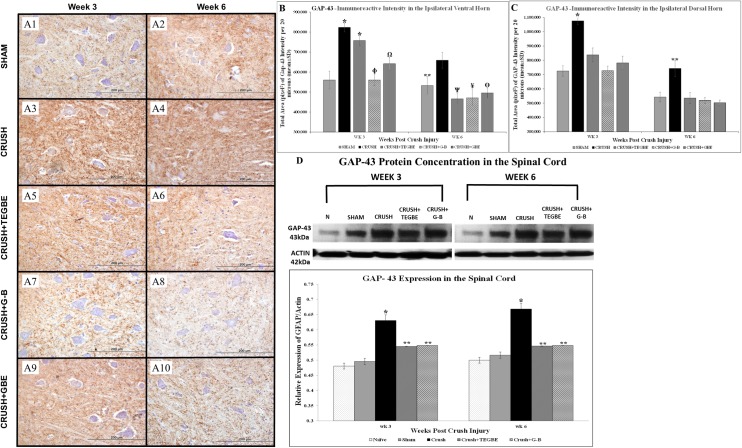
GAP-43 immunoreactivity.A: Representative photomicrographs (40x objective) of ipsilateral ventral grey horn of L3-L6 spinal cords sections from all groups immunostained for GAP-43 (GAP-43 Antibody (B-5): sc-17790 –Santa Cruz Biotechnology) at week 3 (A1, A3, A5, A7 and A9) and week 6 (A2, A4, A6, A8 and A10) following nerve crush injury. Note that the crush group (n = 12) (A3, A4) display a remarkable increase in GAP-43 immunoreactivity when compared to sham (n = 12) (A1, A2) group at week 3 and week 6 post-injury. Whereas treated animals with TEGBE (n = 12) (A5, A6), G-B (n = 12) (A7, A8) and GBE (n = 6) (A9, A10) show a prominent decrease in GAP-43 immunoreactivity in the ventral horn compared to sham group at week 3 and week 6 following sciatic nerve injury. Scale bar = 200 μm. B, C: Bar graphs showing the average GAP-43 immunoreactive areas in the ventral grey horn (B) dorsal grey horn (C) of the spinal cord and obtained from the different experimental groups at week 3 and week 6 following sciatic nerve injury. Note that the significant increase in the GAP-43 immunoreactive intensities in the ventral (B) and dorsal (C) horns of the crush animals compared to sham group at week 3 and week 6 post-injury. Whereas the EGBE, G-B and GBE-treated groups showed significant decrease intensity of the GAP-43 immunoreactivity at week 3 and week 6 compared to crush group. B: * indicates p<0.0001, crush group and TEGBE-treated group vs. sham group. ɸ indicates p<0.0001, G-B-treated group vs. crush group and TEGBE-treated group. Ω indicates p<0.005, GBE-treated group vs. crush group. ** indicates p<0.03, sham vs. CRUSH = group. Ѱ indicates p<0.002, TEGBE-treated group vs. crush group. ¥ indicates p<0.003, G-B-treated group vs. crush group. ϴ indicates p<0.006, GBE-treated group vs. crush group. C: * indicates P<0.0001, crush vs. sham and all treated groups. ** indicates p<0.002, crush vs. sham and all treated groups. The intensity area in pixel2 was measured using Cell-Sens software of 20x magnification of all sections (n = 6 /group). Data represent mean ± SEM. Scale bar = 20 μm. D: Illustrates the Western blot graph and the statistical data analysis of the GAP-43 expression in the spinal cords obtained from the experimental groups. In each group, the lumbar spinal cords from three rats were analyzed at week 3 and week 6 post-injury. The bar graph shows the GAP-43 immunoreactive intensities in spinal cord samples (n = 3 rats/group) normalized with densities of actin band (Molecular weight-42). The labeled GAP-43 bands were quantified. Note that the significant (*p<0.0001) increase in the GAP-43 expression is in the crush group compared to all groups at week 3 and week 6 post nerve injury. Whereas the TEGBE and G-B treatments induced a substantial decrease in GFAP immunoblotting, but still significantly (**p<0.05) higher compared to naive animals (n = 6) at weeks 3 and 6 post-injury.